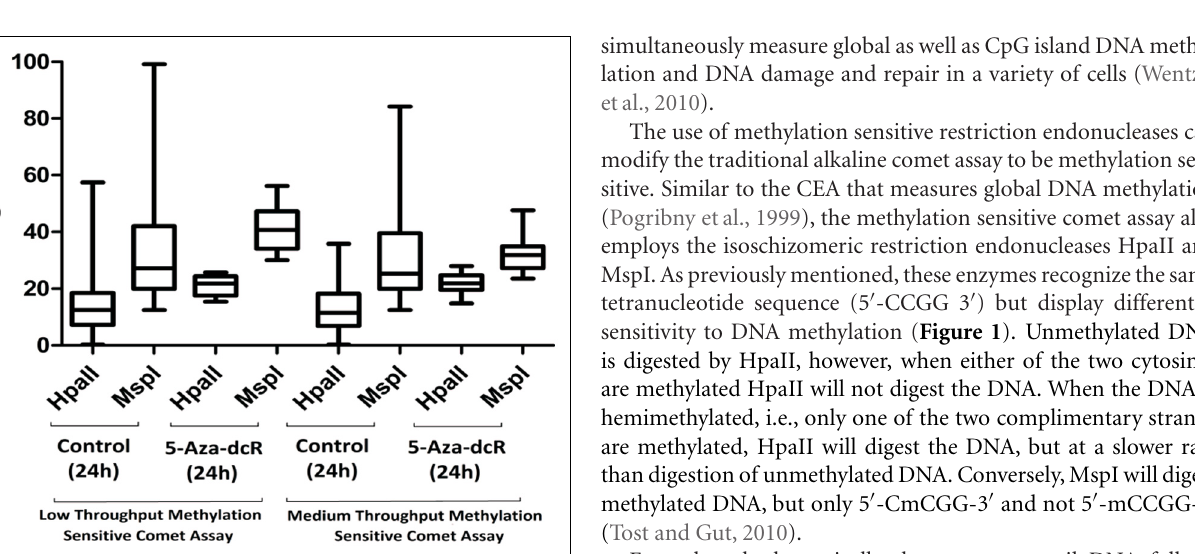
FIGURE 3 |A comparison of the percentage tail DNA in comets of cells cultured under normal conditions in comparison with cells treated with the demethylation agent 5-Aza-dcR as measured with the low- and medium-throughput methylation sensitive comet assays. A bootstrap replication number of 10,000 were employed with a 95% confidence interval. All experiments were at least performed in triplicate with two independent